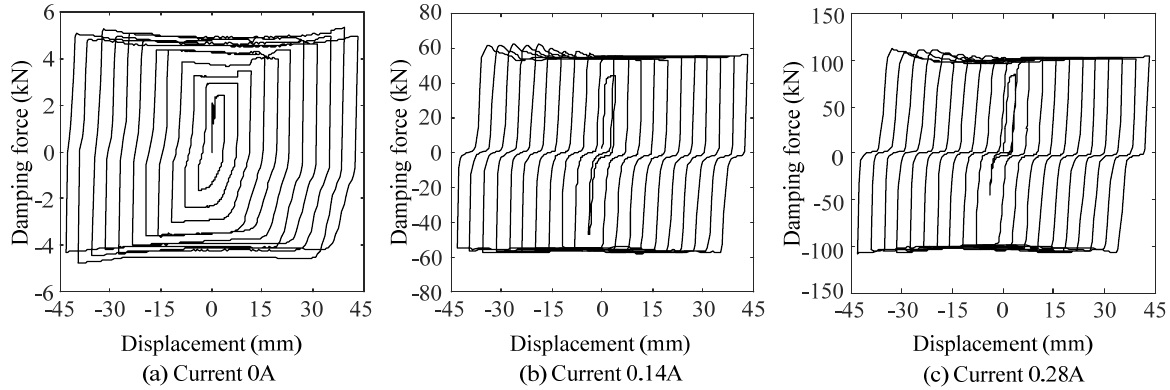
Figure 3. Damping force-displacement hysteresis curve of the MRD at different currents.